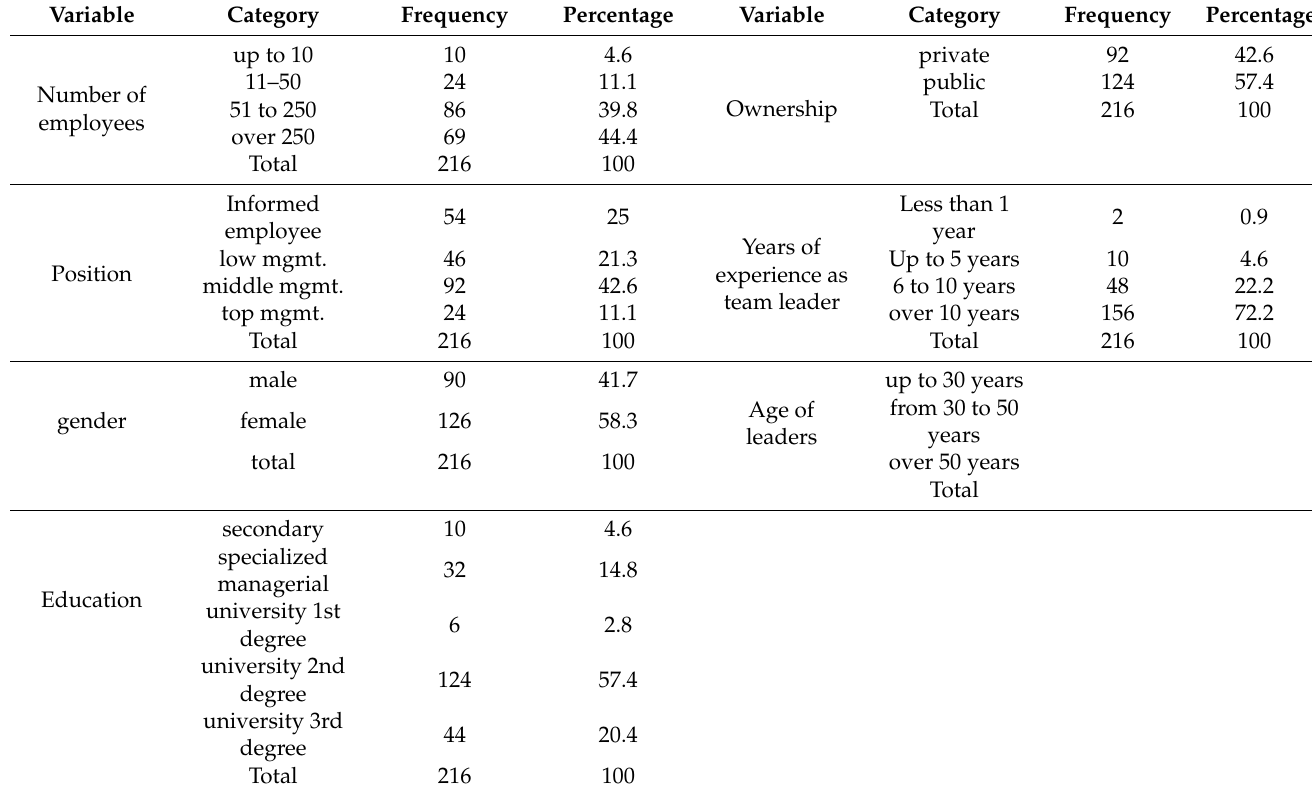
Table 1. Structure of the examined sample of healthcare facilities. Source: authors’